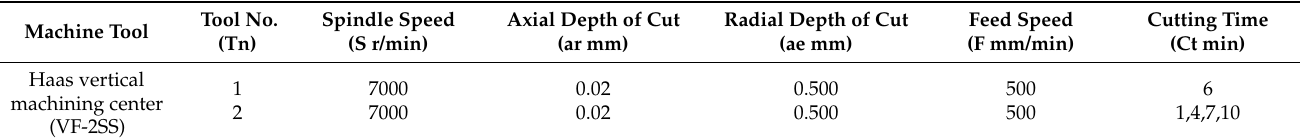
Table 2. Machining parameters used during micro end milling.